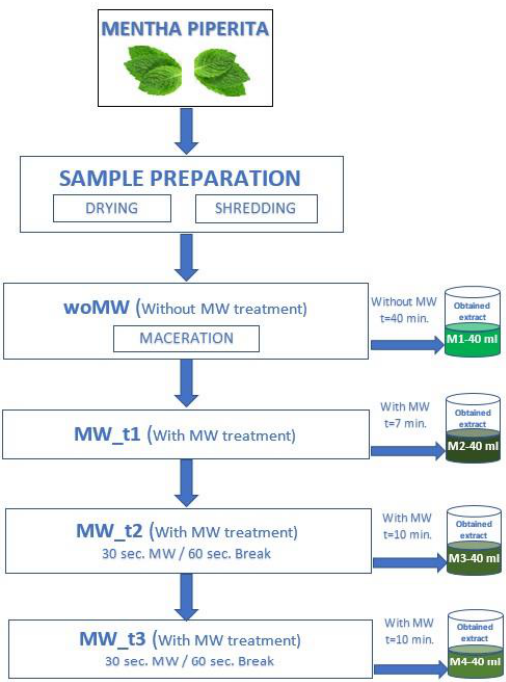
Figure 1. Experimental design (DOE).